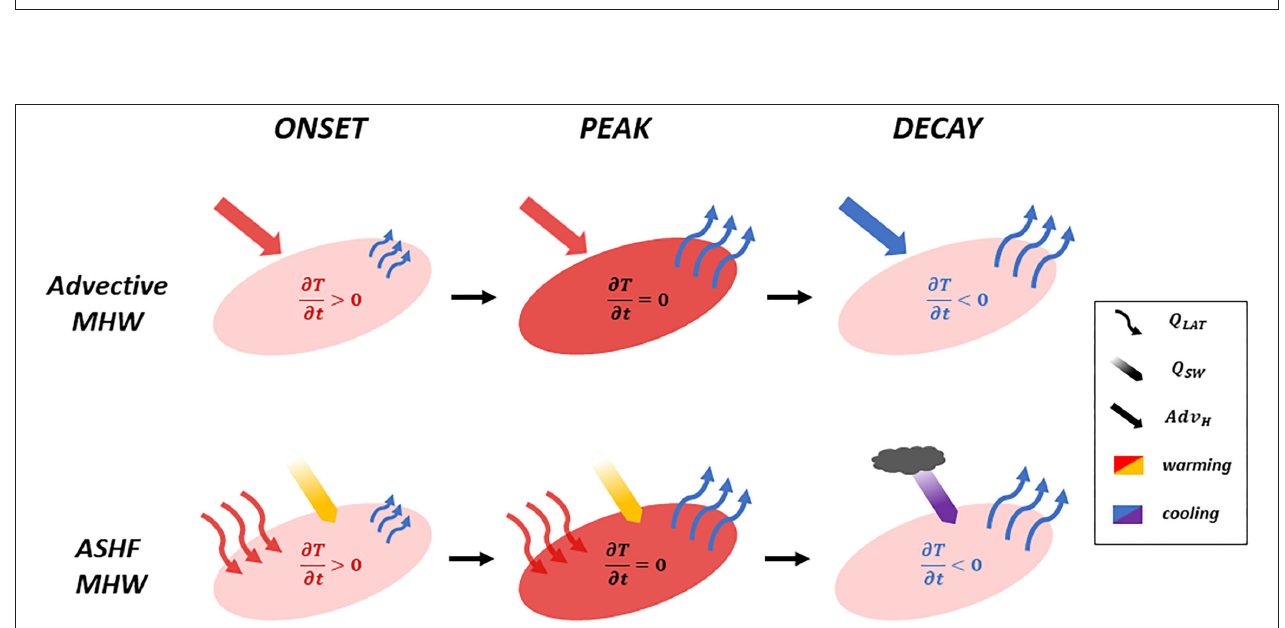
FIGURE 10 | Mechanisms of upper ocean temperature feedback responses associated with an extreme advective and air-sea heat flux (ASHF) driven MHW during the onset, peak and decay periods.